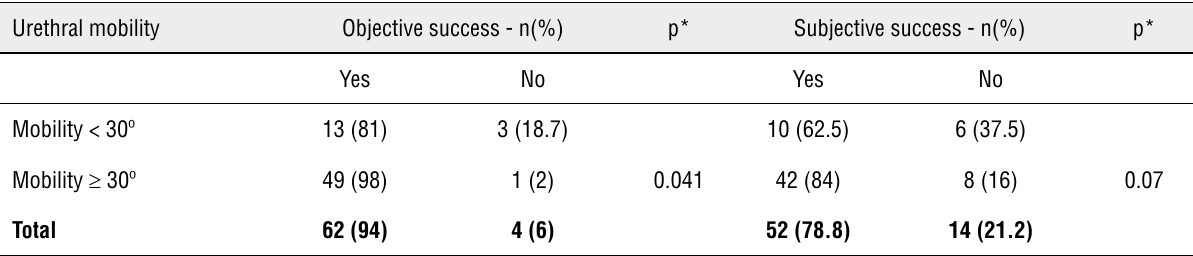
Table 1 - Influence of urethral mobility on postoperative success rates. Urethral mobility Objective success -